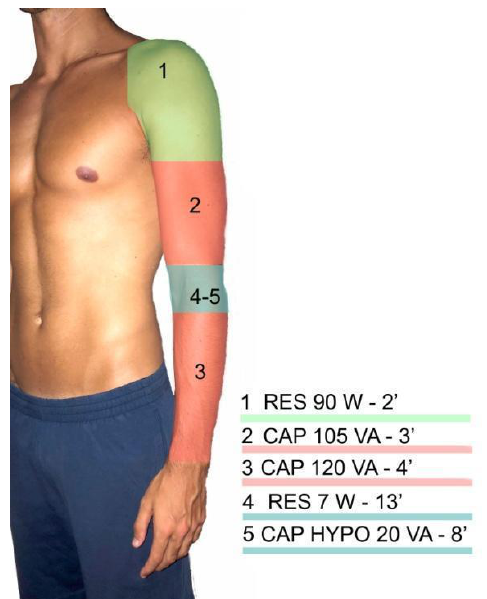
Figure 1. Applications used during the protocol. RES, resistive; W, watts; CAP, capacitive; VA, volt-amperes; CAP HYPO, hypothermic capacitive.